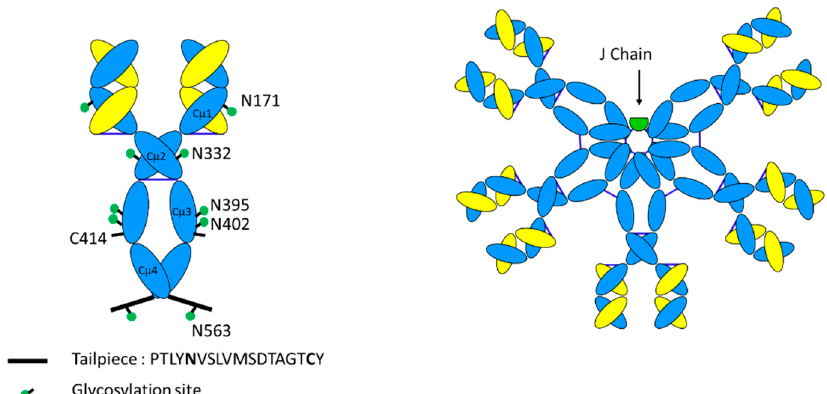
Figure 4. Schematic diagram of IgM monomer vs. IgM pentamer. IgM monomers are distinguished from IgG counterparts by their extensive glycosylation at the asparagine residues indicated, the presence of an additional domain Cµ2 in place of a hinge, and the presence of a short tailpiece peptide sequence that is critical for multimerization. Pentameric IgM has an additional 137 amino acid joining (J)-chain.